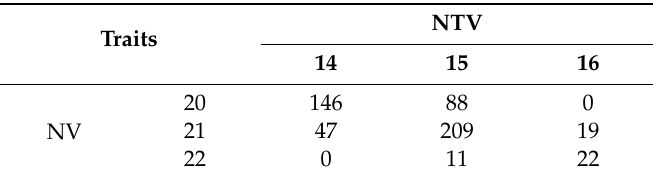
Table 1. The distribution of the number of thoracic vertebrae in di ff erent groups with di ff erent numbers of thoracolumbar vertebrae.